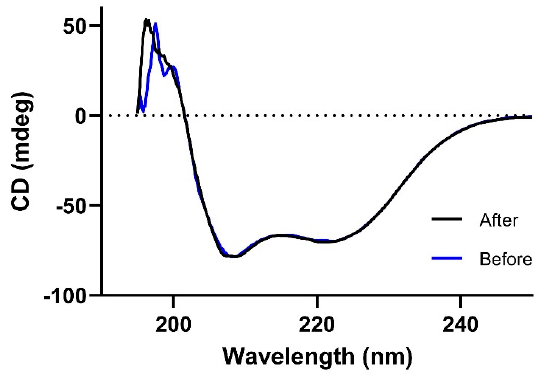
Figure 2. CD spectra recorded at 20 °C before (blue line) and after (black line) heating to 90 °C. The data confirm refolding after heat denaturation.